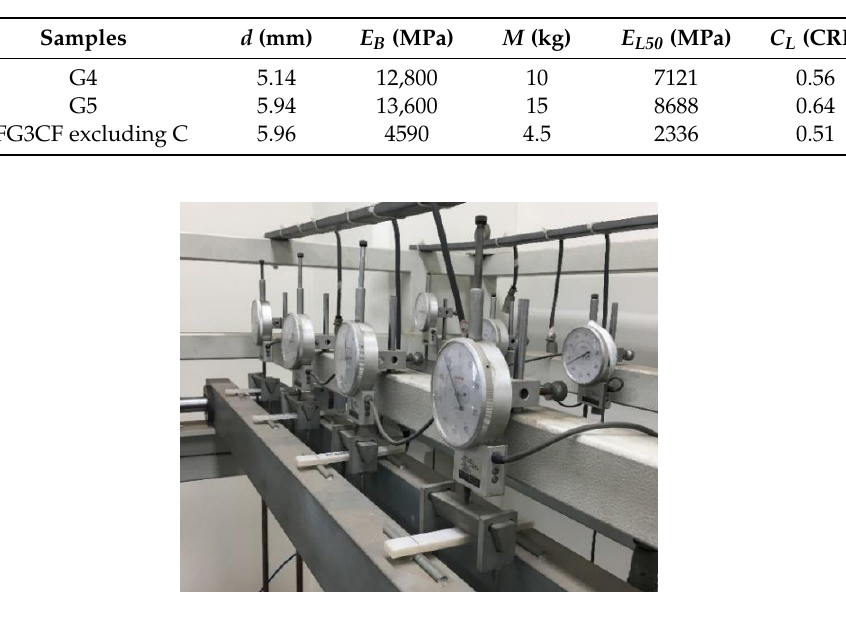
Figure 6. Creep test loading.